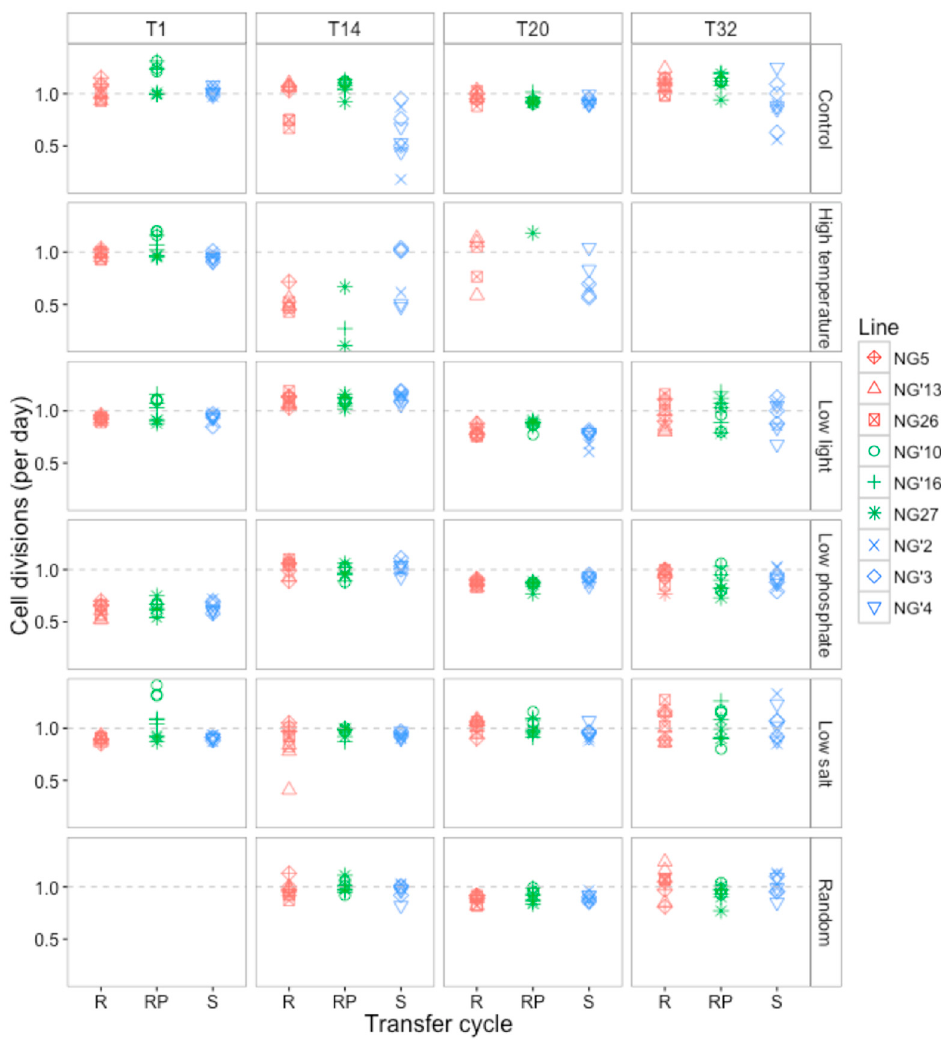
Figure 3. Growth rates as measured by mean cell divisions per day for each evolving population over four time points (1, 14, 20 and 32 transfer cycles). The dashed line represents one cell division per day. T1 is the growth rate following acclimation at the beginning of the experiment. There are no growth measurements for the randomized environment at T1 because lines had only been growing for one transfer cycle.